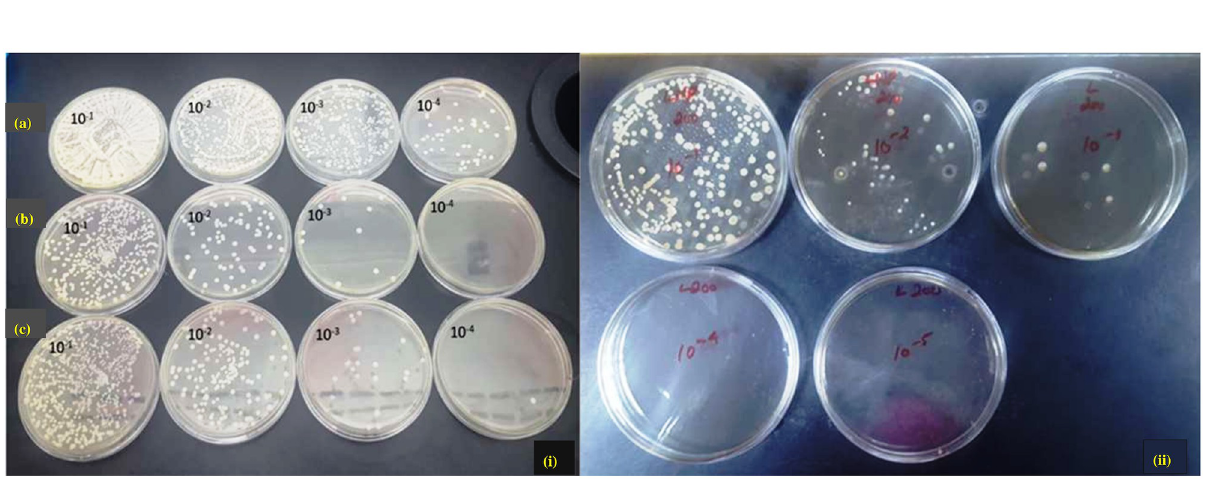
Fig 3. CFU counts of C. albicans at different dilutions; (i) (a). tissue conditioner discs without chitosan (control), (b). tissue conditioner discs with ECO 200, (c). tissue conditioner discs with ECO 250 and (ii) tissue conditioner discs with ECL 200, control TC disks were easily colonized by C . albicans till the last dilution whereas experimental TC disks hindered the growth of C . albicans rapidly. At the 10 − 3 dilution, there was negligible growth on the plate for ECO 200, ECO 250, and ECL 200.